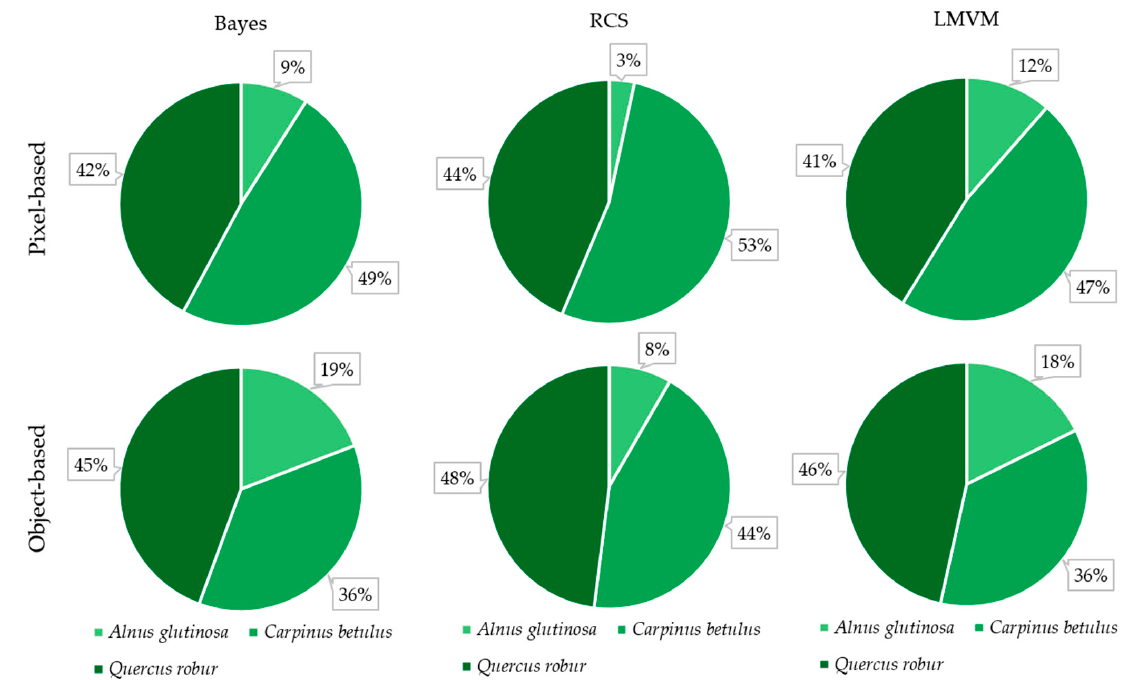
Figure 5. The share of the tree species classes for pixel- and object-based classification of three pansharpened imagery (Bayes, RCS, LMVM).